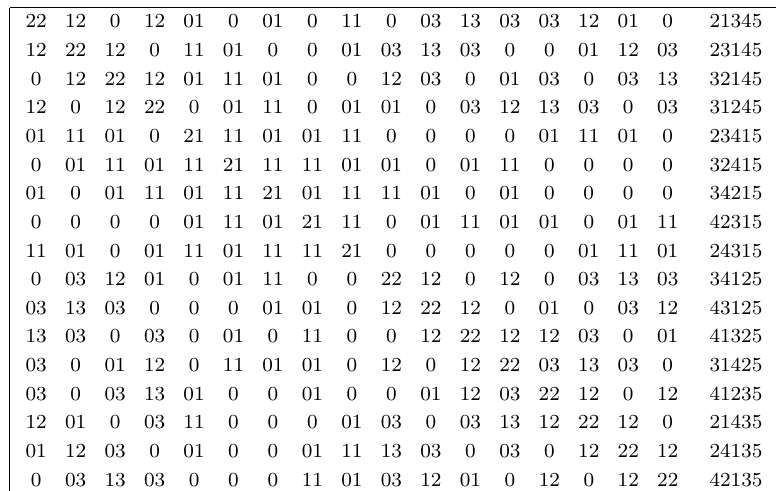
F ( j ) qg , and a single 0 means that c